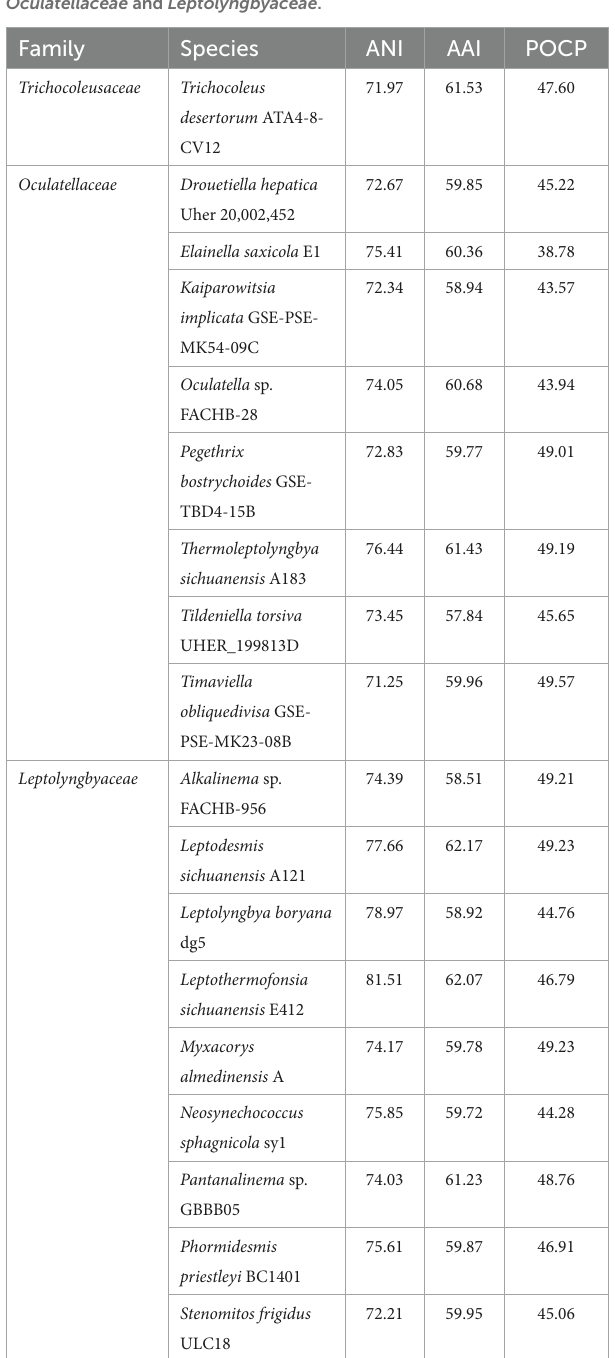
TABLE 4 Indices values (%) of whole genome comparisons between strain B231 and representative species from Trichocoleusaceae , Oculatellaceae and Leptolyngbyaceae